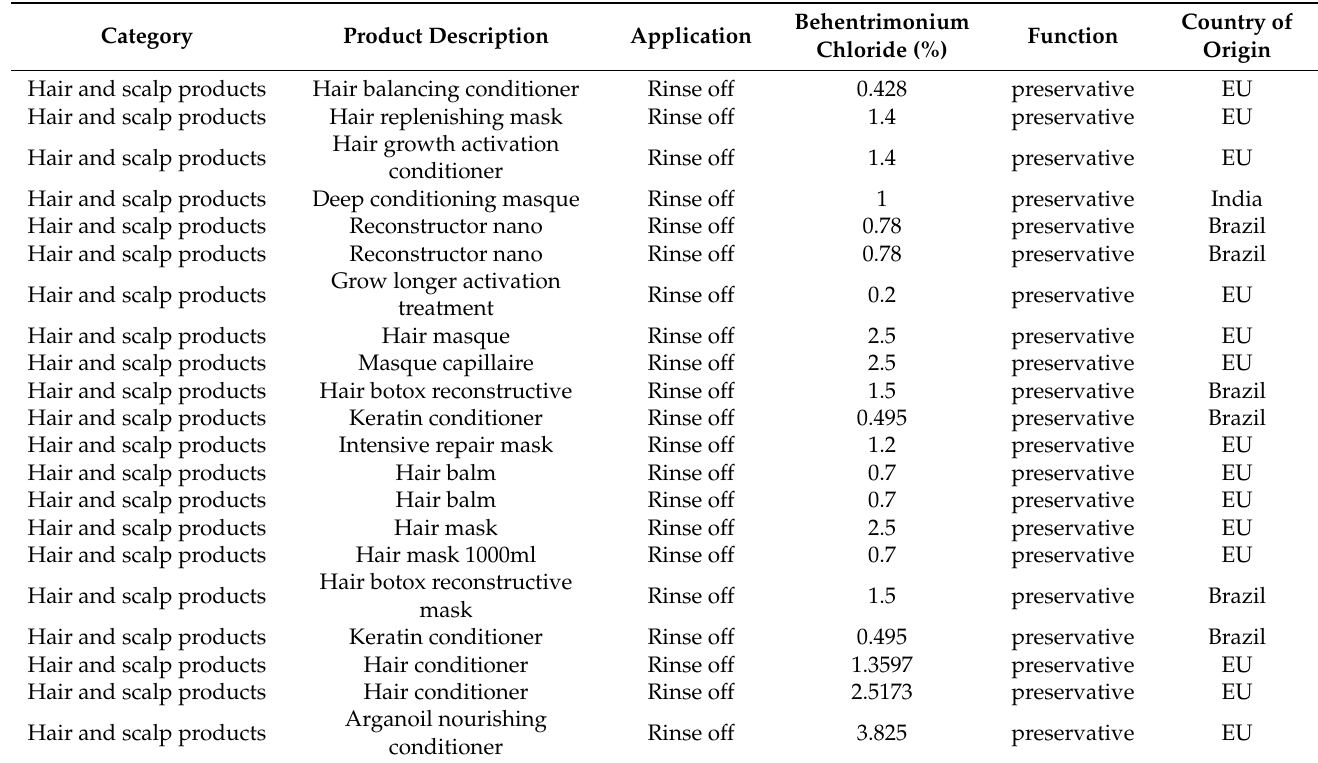
Table 5. List of analyzed cosmetics and personal care products exceeding the maximum allowable limit of Behentrimonium chloride used as a